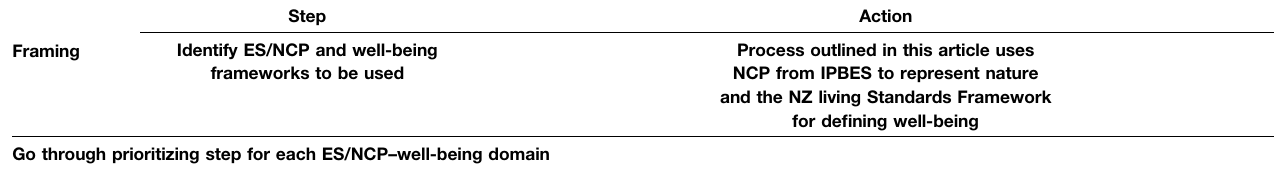
TABLE 2 | Summary of the process and questions used to apply the impact and substitutability criteria to each ES/NCP – well-being domain.